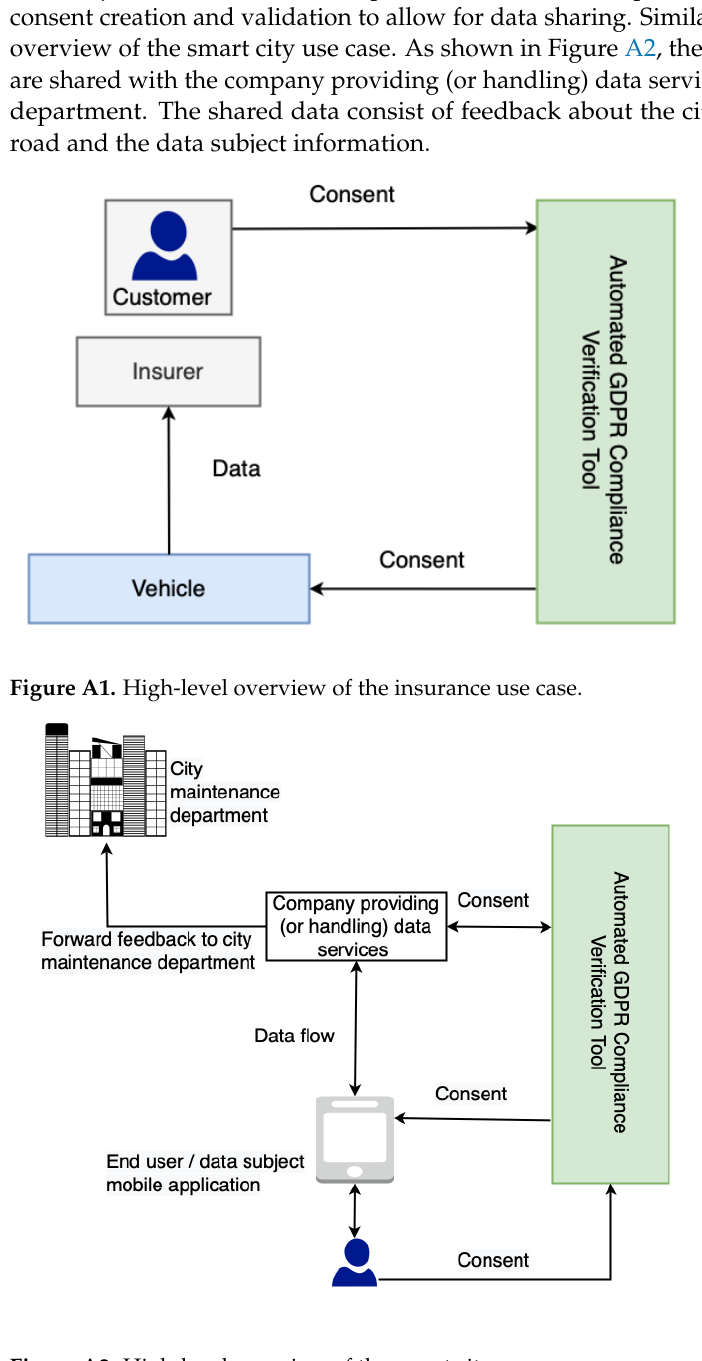
Figure A2. High-level overview of the smart city use